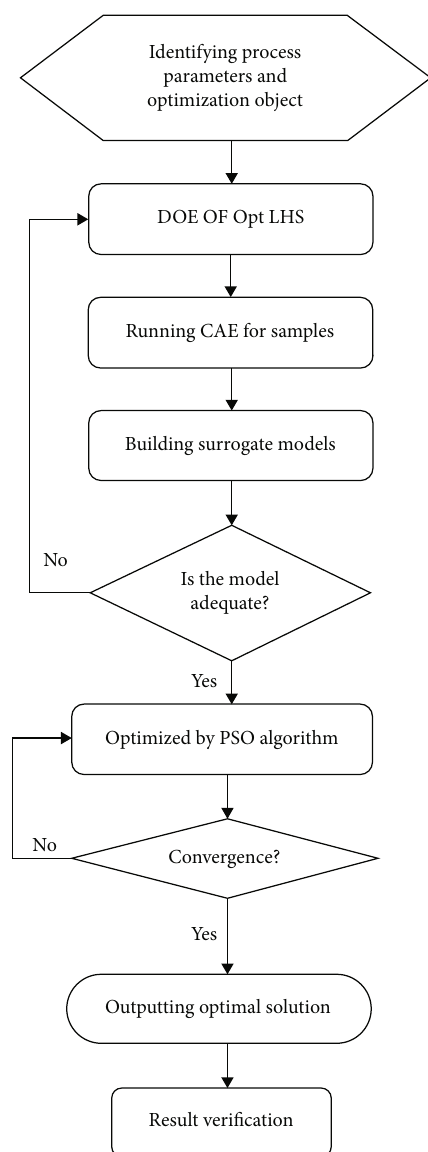
Figure 2: Flow chart of hybrid optimization